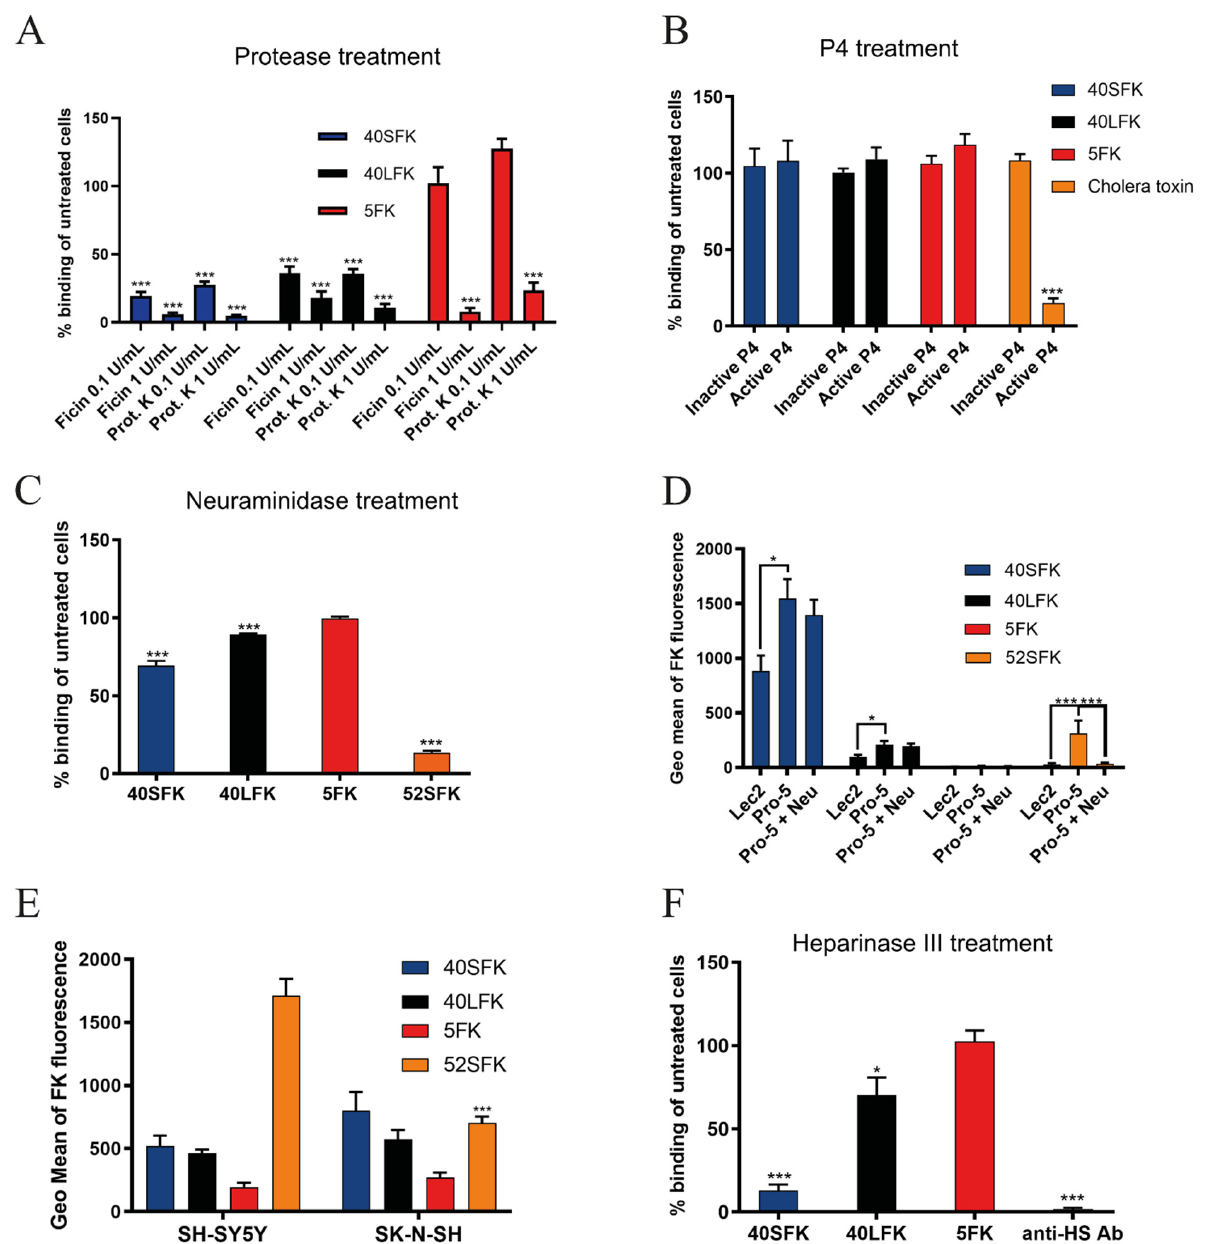
Figure 1. Receptor characterization for the short fiber of HAdV-F40: recombinant fiber knob binding to ( A ) A549 cells pretreated with the proteases—ficin and proteinase K—which degrade cell surface proteins; ( B ) A549 cells pretreated with P4—which inhibits glycolipid synthesis; ( C ) A549 cells pretreated with V. cholerae neuraminidase—which cleaves sialic acid. ( D ) CHO cells expressing or lacking sialic acid pretreated with V. cholerae neuraminidase (Neu). Pro-5 cells express sialic acid and Lec2 cells lack sialic acid expression. ( E ) SHSY-5Y cells expressing polysialic acid and SK-N-SH lacking polysialic acid, ( F ) A549 cells pretreated with heparinase III—which cleaves heparan sulfate. Binding was determined by geometric mean of fluorescence on a FACSLSRII flow cytometer and shown as % binding of fiber knobs on untreated cells in ( A – C , F ). All experiments were performed three times with duplicate samples in each experiment. Error bars represent mean ± SEM. * P < 0.05 and *** P < 0.001 versus control.